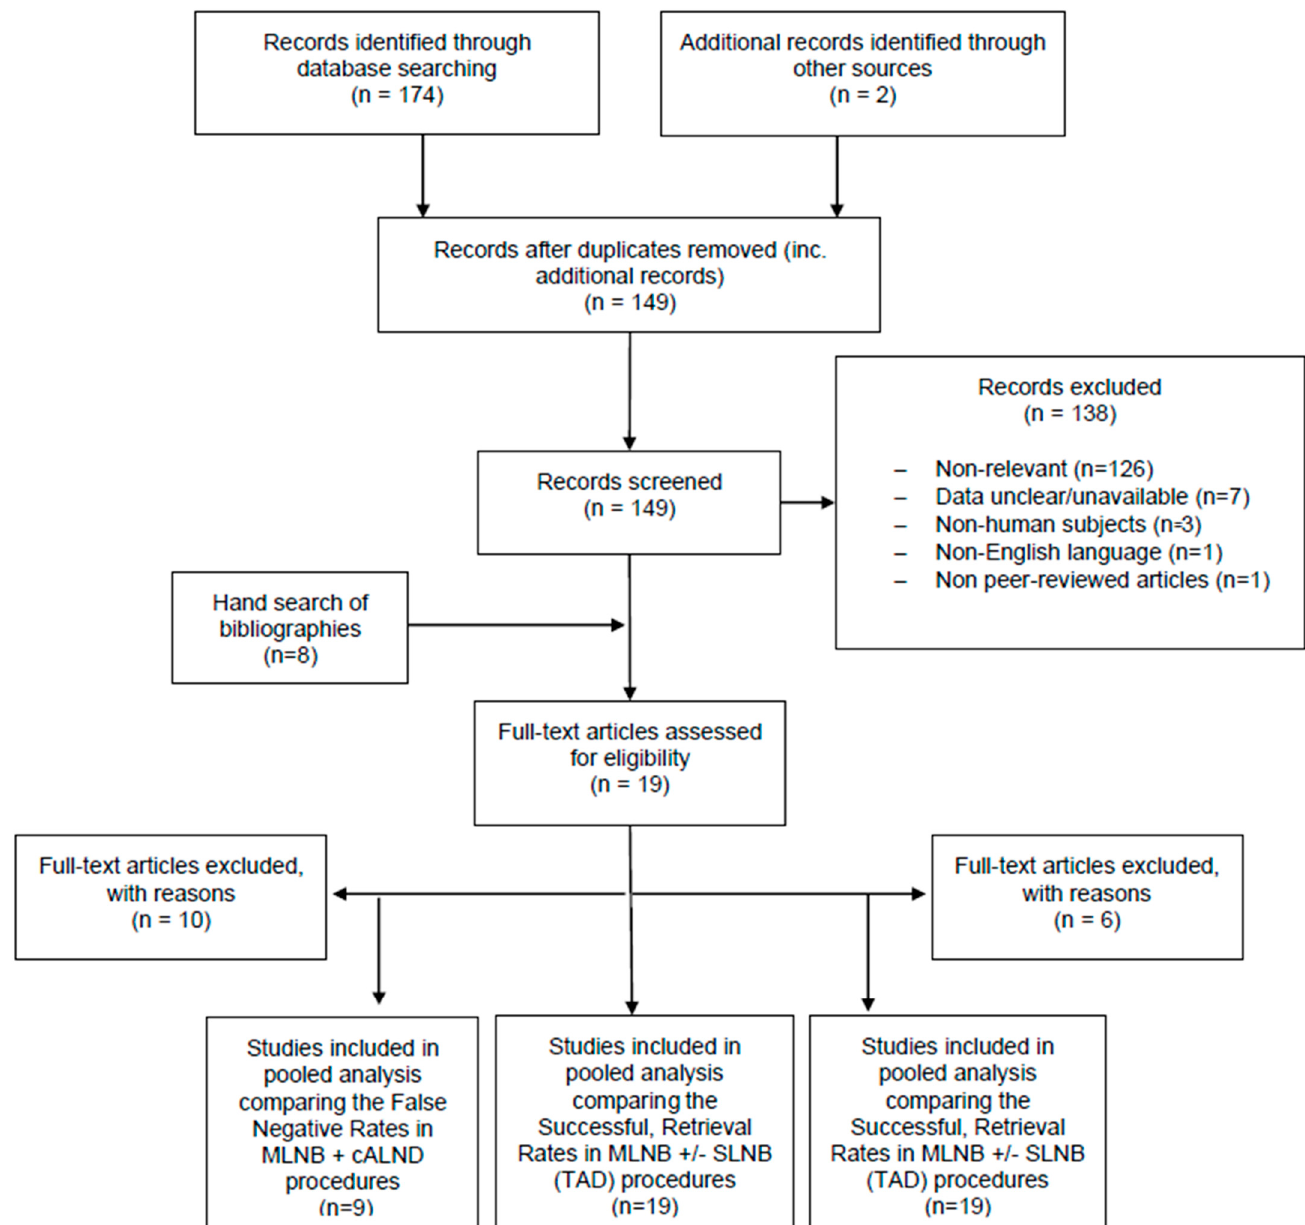
Figure 1. A PRISMA flow chart summarizing the results of data collection .